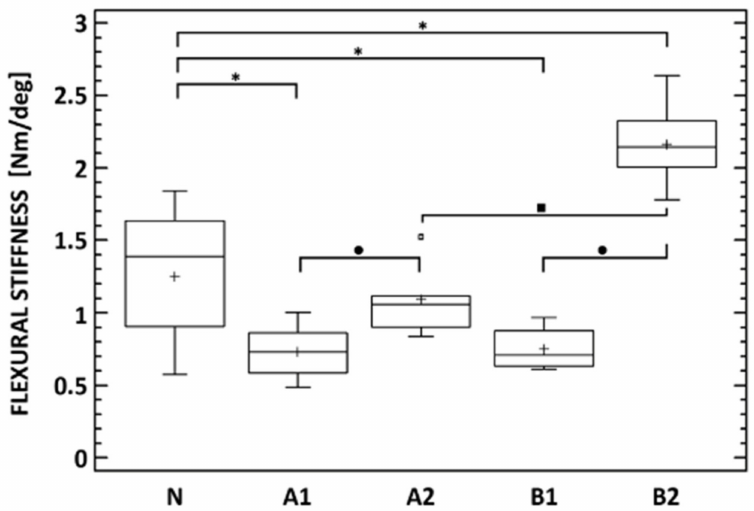
Figure 13. Flexural stiffness of native lumbar spine cadavers (N), specimens 8 (A1) and 16 (A2) weeks after lumbotomy and autologous Iliac crest bone graft insertion into the L2/3 intervertebral space, and specimens 8 (B1) and 16 (B2) weeks after lateral lumbar interbody fusion (L2/3) with the nanocomposite porous implant. * Denotes statistically significant differences determined between any of the treated groups and the native cadavers. • denotes statistically significant differences between the time points of each of the A and B groups. ▪ denotes statistically significant differences between the A and B group at each of the time points (Mann–Whitney test, p <